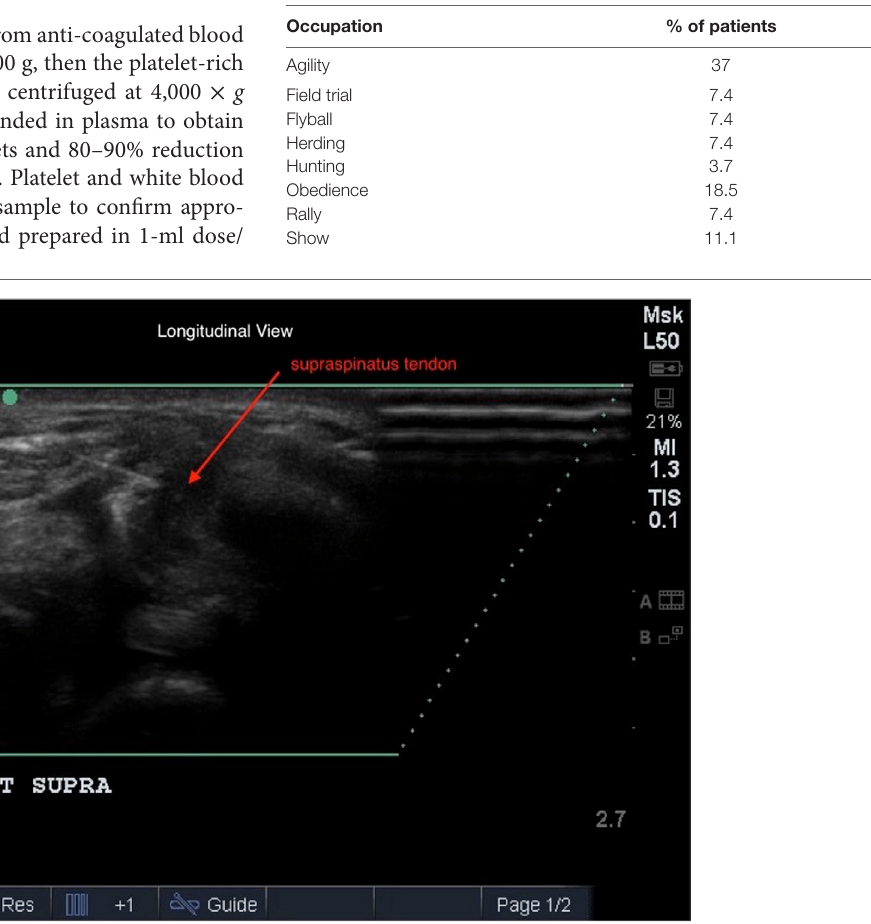
TaBle 2 | Patient